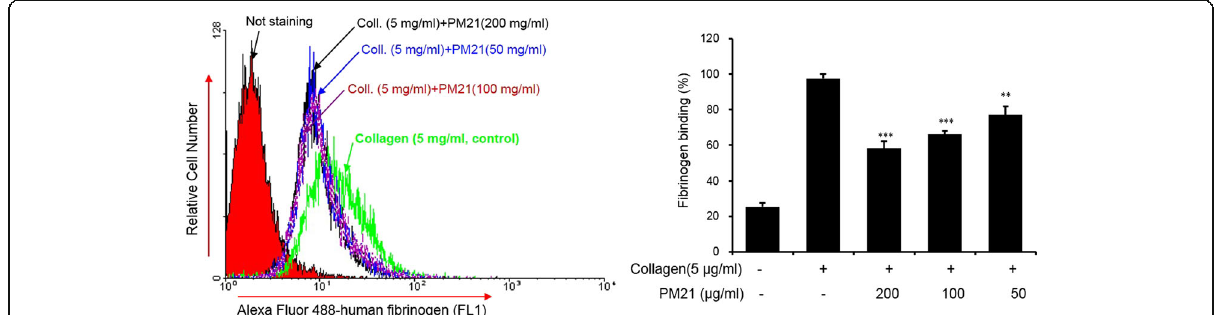
Fig. 3 Effects of PM21 on collagen-induced fibrinogen binding to integrin α IIb β 3. Rat platelets were pre-incubated for 2 min with various concentrations of PM21 (50, 100, 200 μ g/mL), then stimulated with 5 μ g/mL collagen in the presence of Ca 2+ (1 mM) for 5 min, and immediately incubated thereafter with fibrinogen Alexa Fluor 488 (20 μ g/mL) for 5 min. Nonspecific binding of fibrinogen to integrin α IIb β 3 was assessed in the presence of the calcium